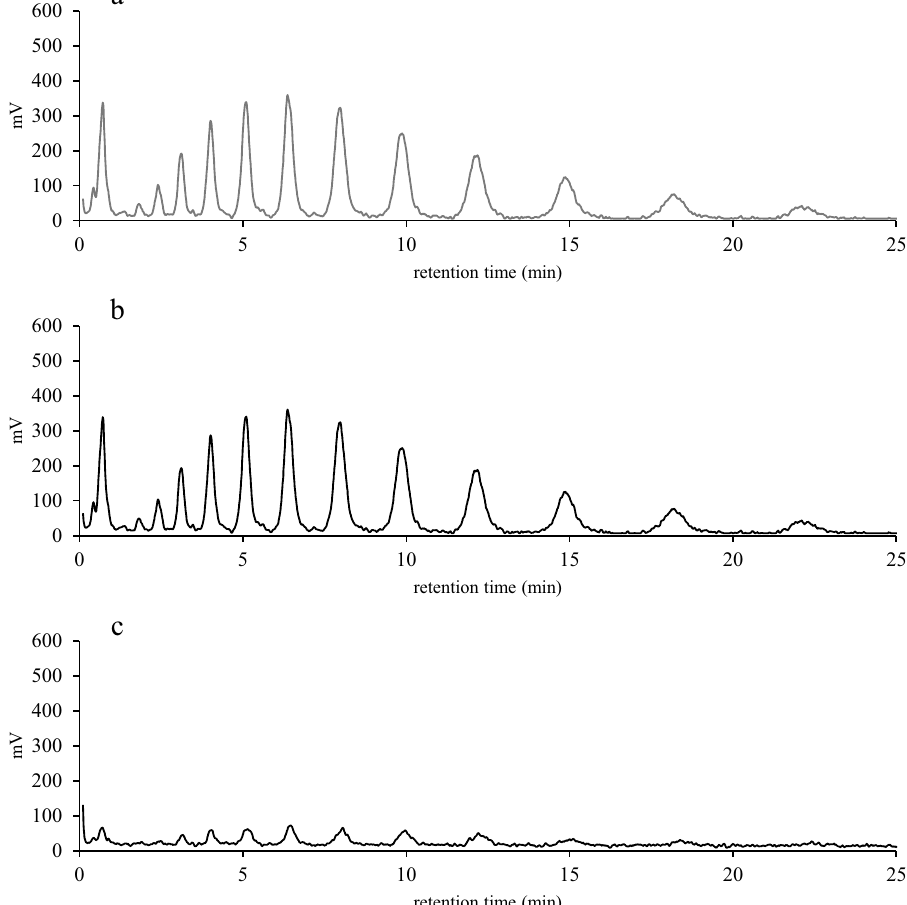
Figure 1. Comparison of extracellular Fuji FFSC inulin levels of JCM 1002 T cells. JCM 1002 T cells, which